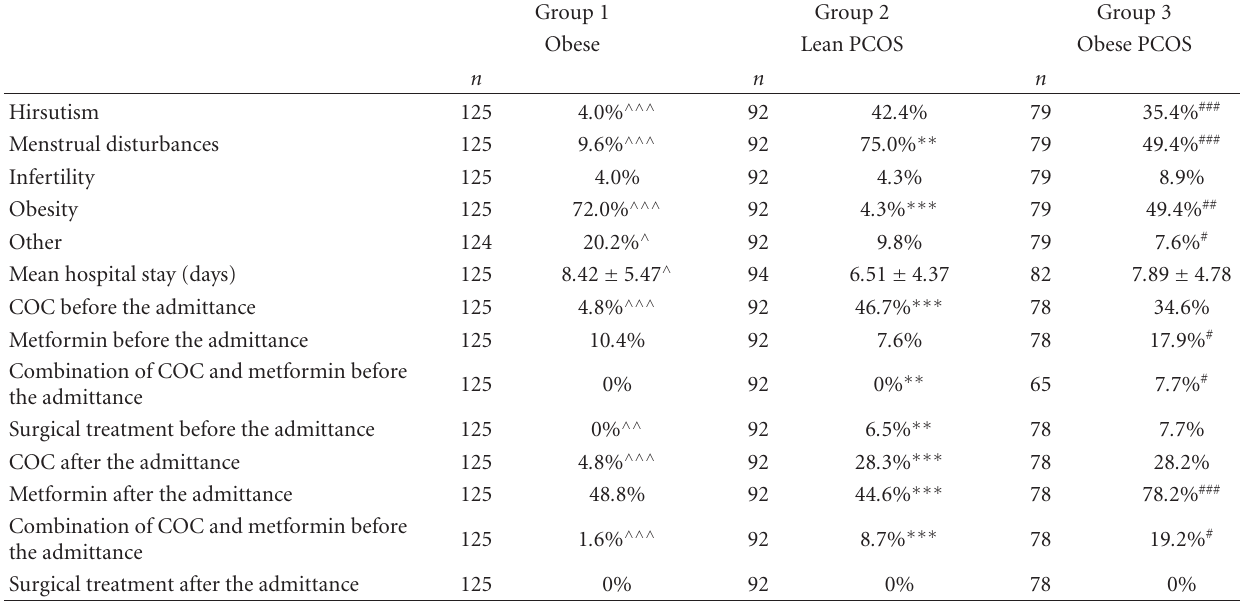
Table 7: Comparison between the reasons for admittance and the type of treatment before and after the admittance between the three groups.